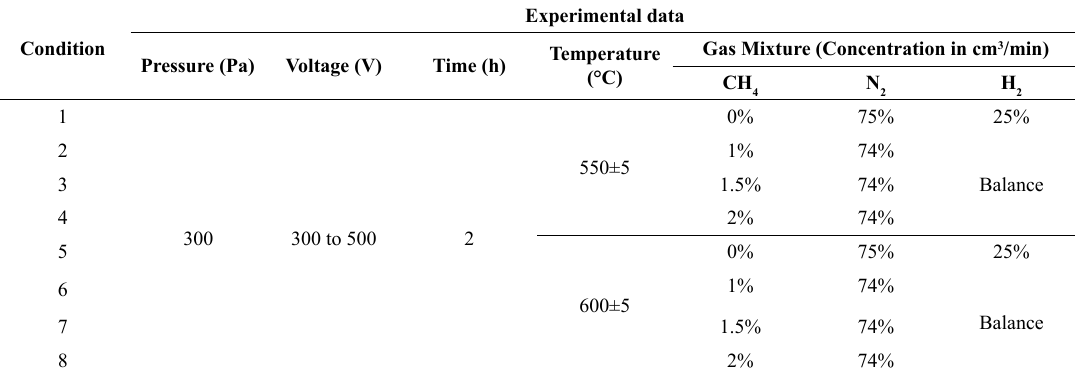
Table 2. Experimental data for the nitrocarburizing process.